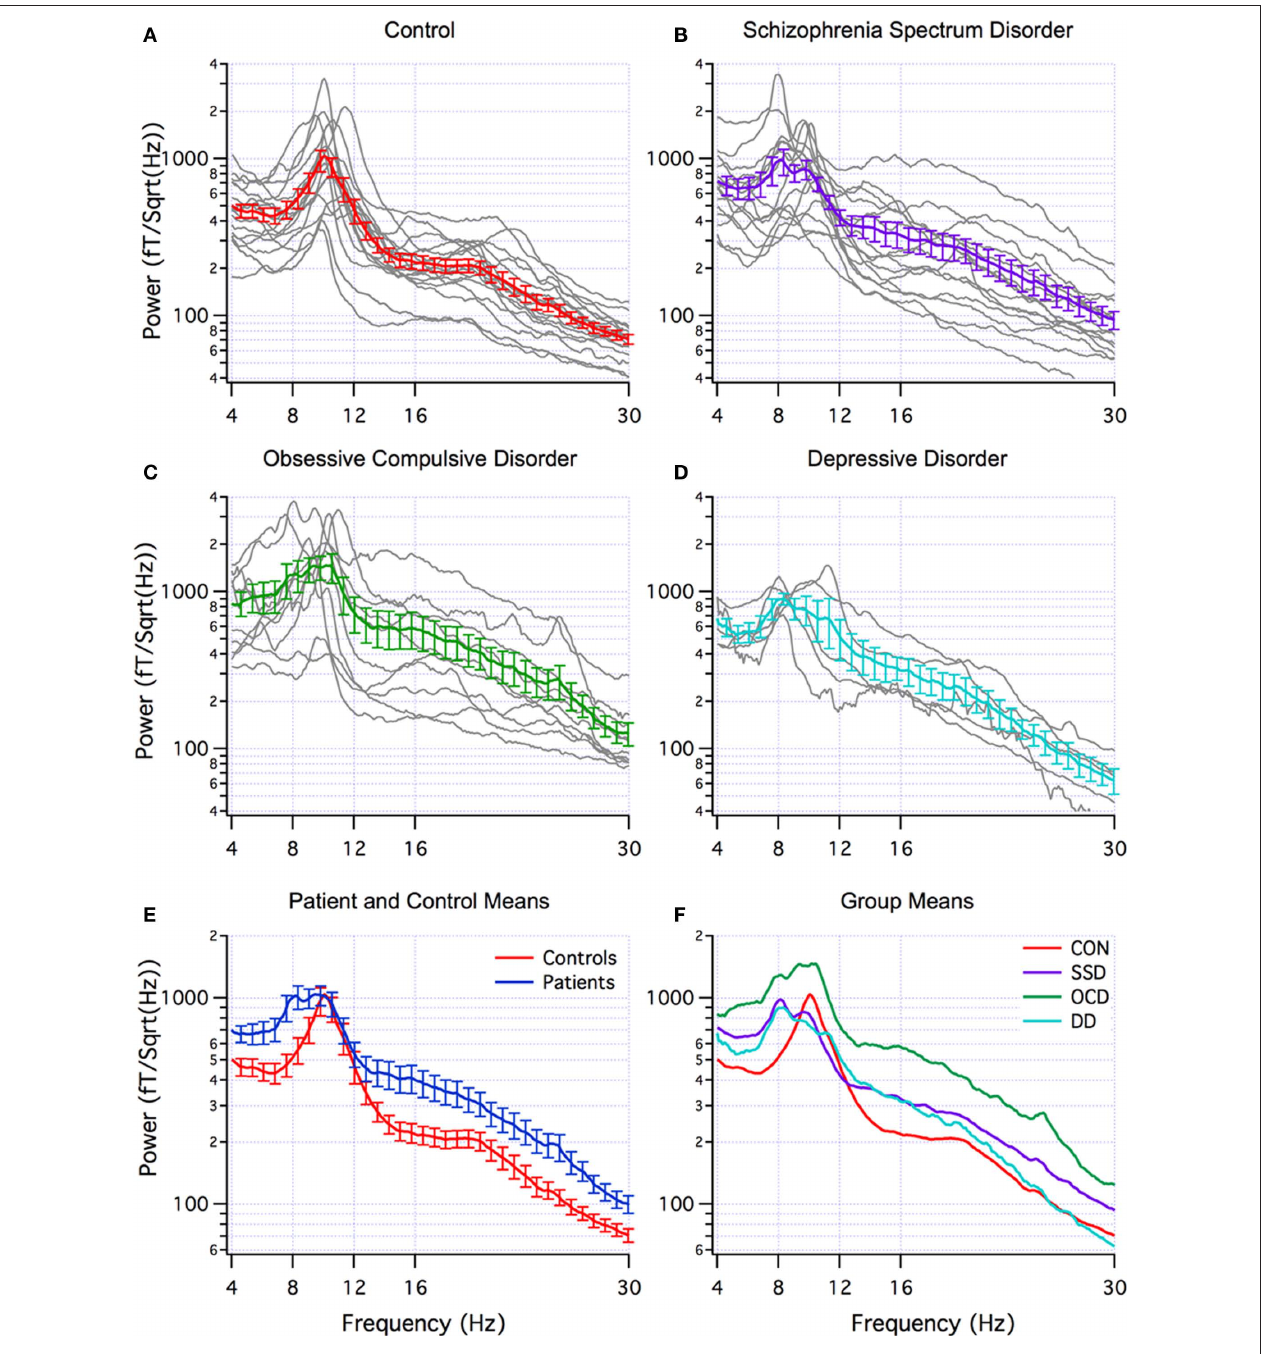
FiGure 1 | Multi-taper power spectra. (A–D) Individual (grey) and mean ( ± SEM) spectra for controls (red, n =18), schizophrenic spectrum disorder (SSD) (purple, n =14), obsessive-compulsive disorder (OCD) patients (green,